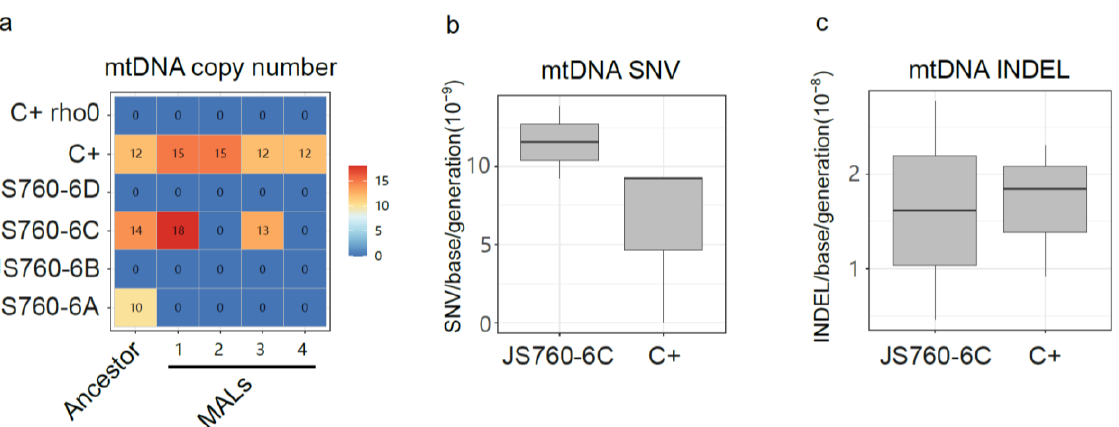
Figure 5. The copy number change and mutations of the mitochondrial genome. ( a ) The mitochon- drial copy numbers of the six ancestor strains and their four MAL replicates. ( b ) The mitochondrial SNV rate. ( c ) The mitochondrial INDEL rate. The genotypes of the six strains are as follows: JS760-6A ( MRPL25 + atp3 G348T ), JS760-6B ( mrpl25 ∆ ATP3 + ), JS760-6C ( MRPL25 + ATP3 + ), JS760-6D ( mrpl25 ∆ atp3 G348T ), C+ (positive control), C+ rho0 (negative